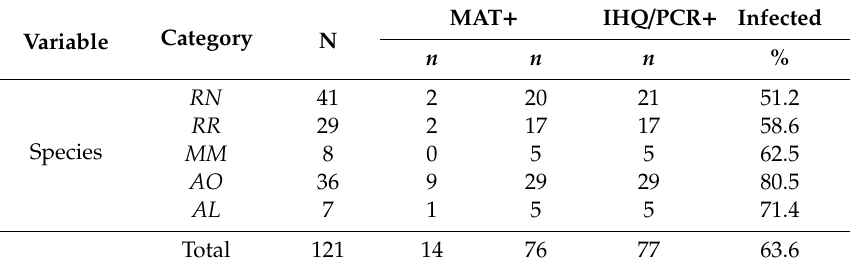
Table 5. Frequency of infected with pathogenic Leptospira spp. rodents in dairy farms in the Los R í os Region, Chile.